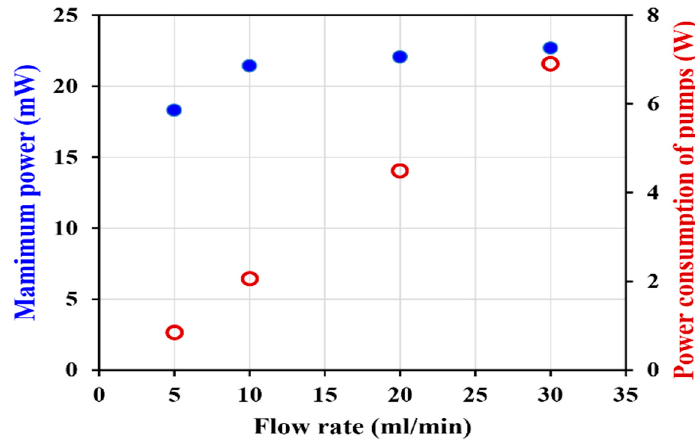
Figure 9. VRFB performance operated with various flow rates.